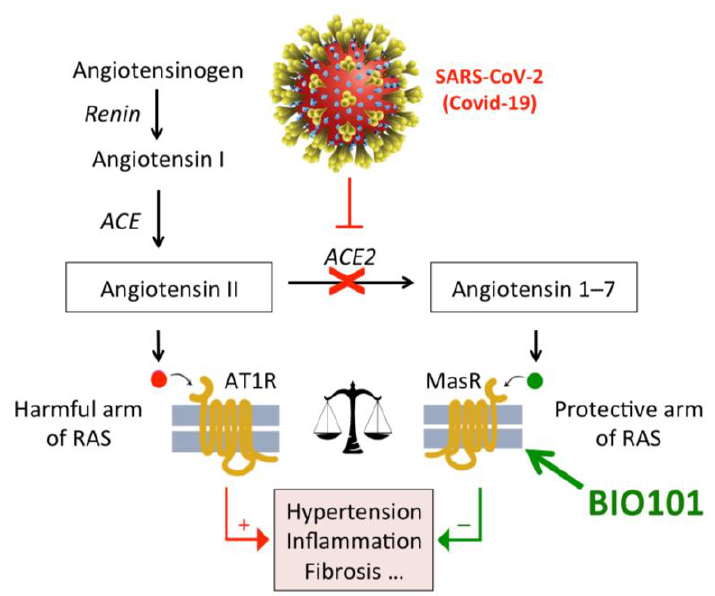
Figure 12. SARS-CoV-2 infection will result in a strong impairment of the activity of angiotensin converting enzyme 2 (ACE2), hence a lack of angiotensin-(1-7) production and a disequilibrium between the harmful and protective arms of the renin–angiotensin system (RAS). Treatment with BIO101 (20E) is expected to activate Mas receptor and the protective arm of RAS, thus preventing inflammation and lung